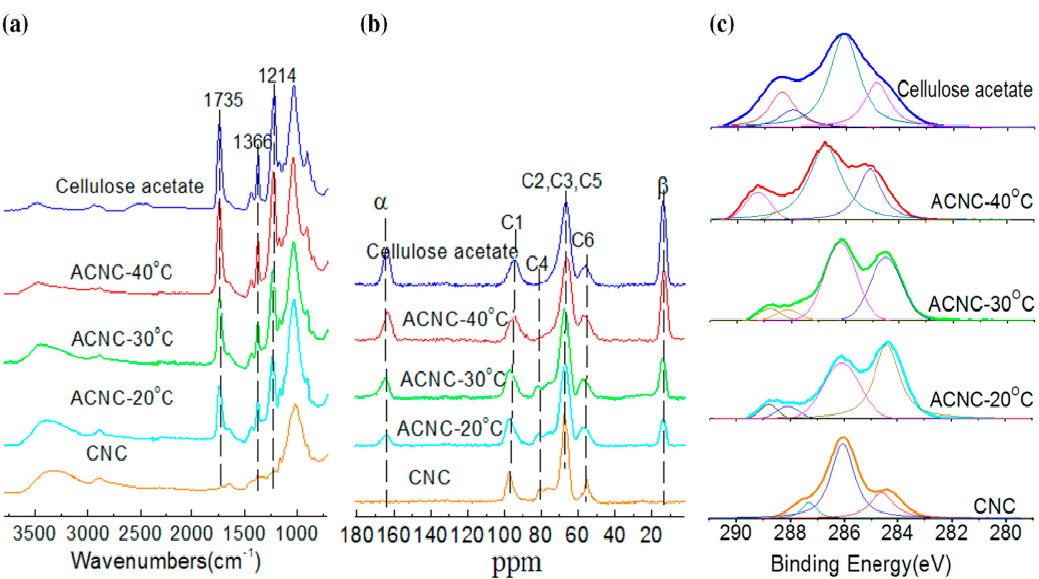
Figure 1. Spectrograms of cellulose acetate for acetylated cellulose nanocrystals (ACNCs) at the following temperatures: ACNC-40 °C, ACNC-30 °C, ACNC-20 °C, and cellulose nanocrystals (CNC): ( a ) Fourier transform infrared spectroscopy (FT-IR) spectra. ( b ) 13 C cross polarization-magic